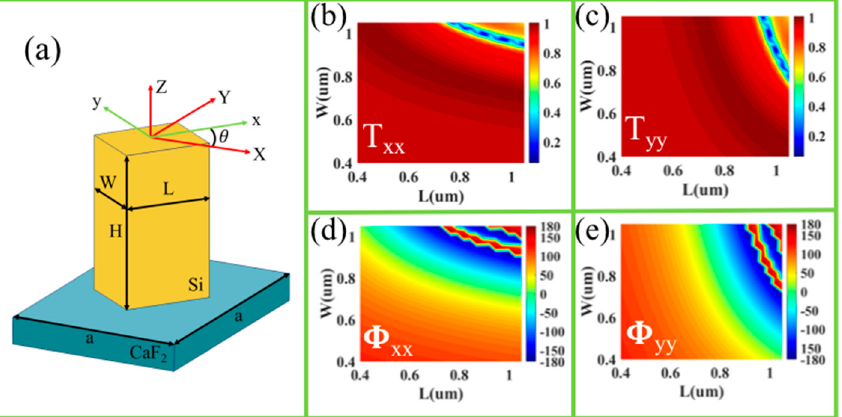
Figure 1. ( a ) Schematic of the Si nanobrick with the rotation angle θ . The transmittances ( b , c ) and the propagation phases ( d , e ) under XLP ( b , d ) and YLP ( c , e ) incidences of the irrotational Si nanobricks as a function of L and W.